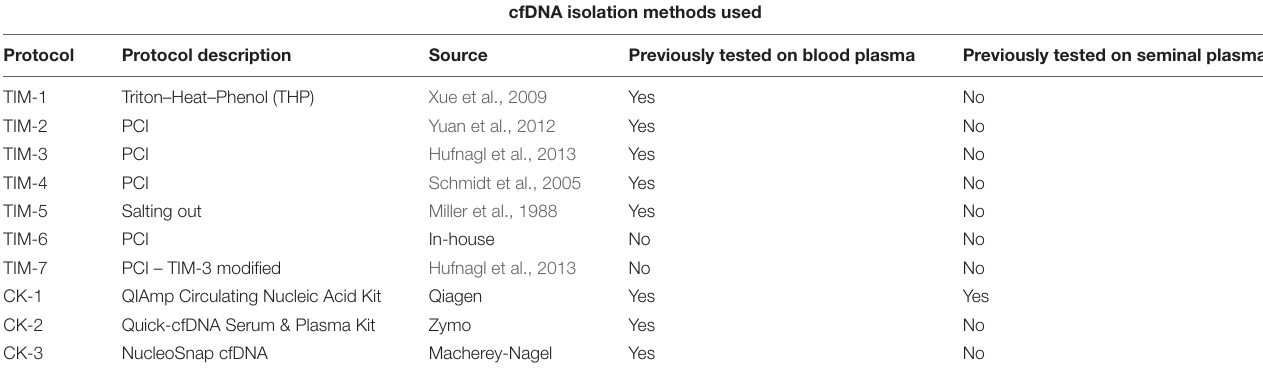
TABLE 2 | List of cfDNA isolation methods used in the study along with their